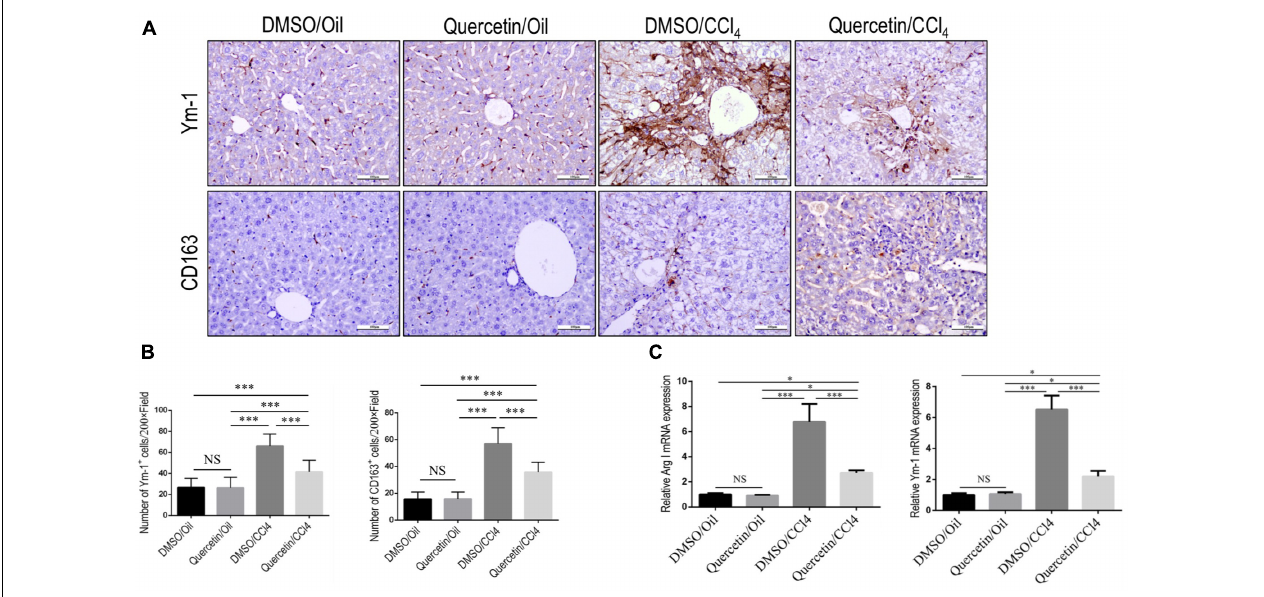
FIGURE 6 | Effect of quercetin on M2 macrophages polarization and expression of immunosuppressive genes in fibrotic livers. (A) Representative immunostaining of Ym-1 and CD163 in liver sections (original magnification: × 200). Scale bar = 100 µ m. (B) Quantification of Ym-1 and CD163 immunostaining in the liver from each group. (C) M2-polarized gene expression of Arginase I (Arg I) and Ym-1 was determined by quantitative RT-PCR, and the results are shown as fold change compared with sham-treated control and GAPDH served as loading control ( n = 5). ∗ P < 0.05; ∗∗∗ P < 0.001; “NS” indicates not significant.